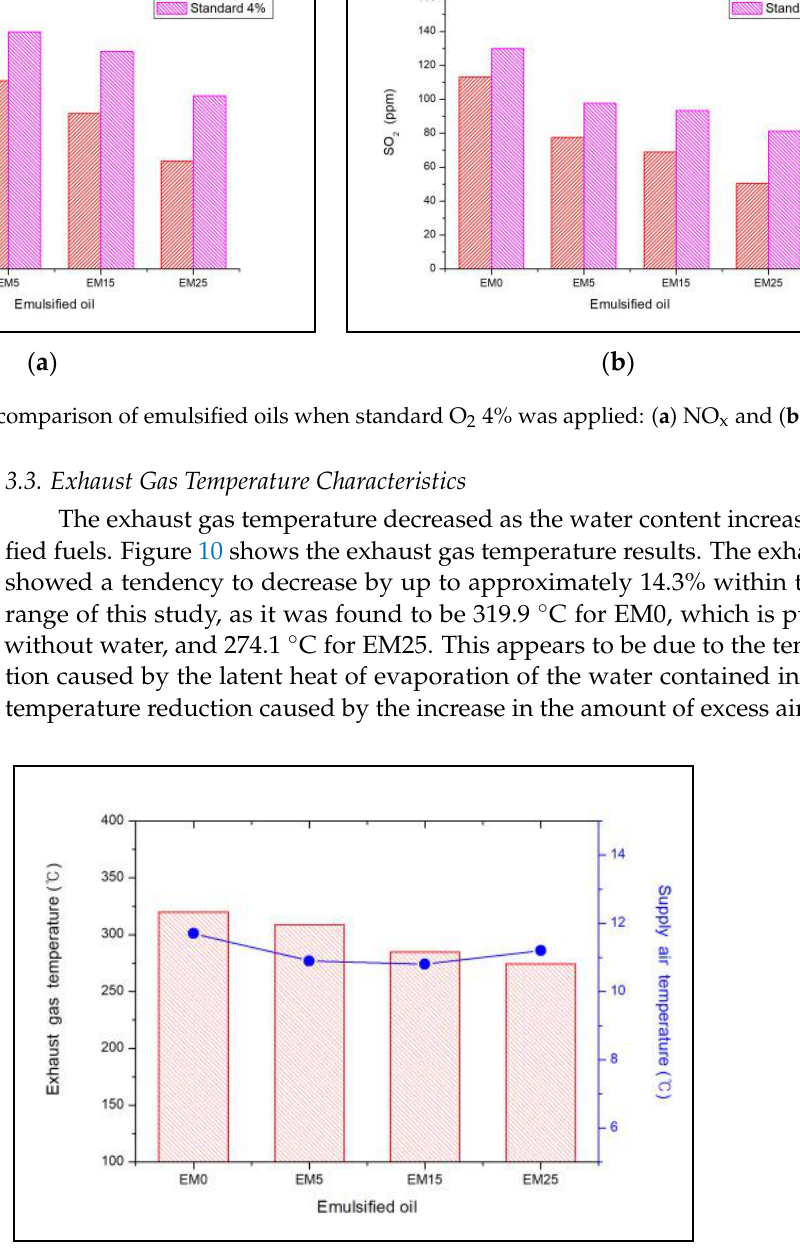
Figure 10. Exhaust gas temperature comparison of emulsified oils.